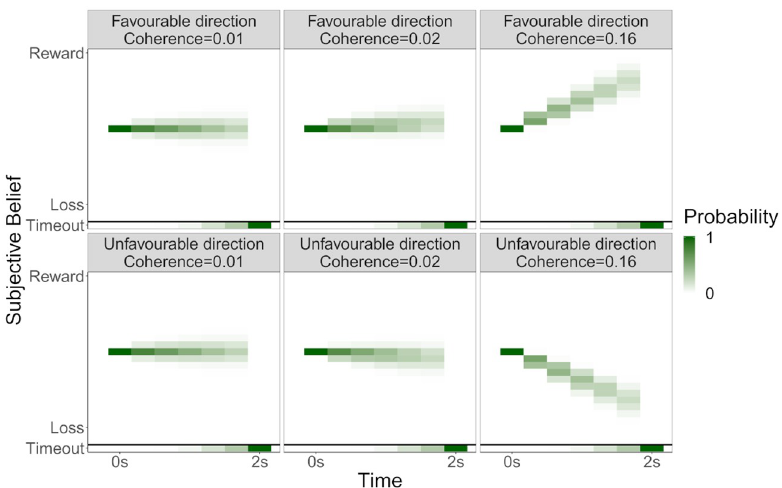
Fig 6. Transition probabilities. Heatmaps illustrating the probability that a participant transitions to each state given the stimulus (i.e., true values of μ and θ ). The coherence level ( θ ) governs the rate of the transition towards a stronger belief that the ‘stay’ response will lead to a reward or loss; and the direction of the stimulus ( μ ) governs the direction of the transitions.